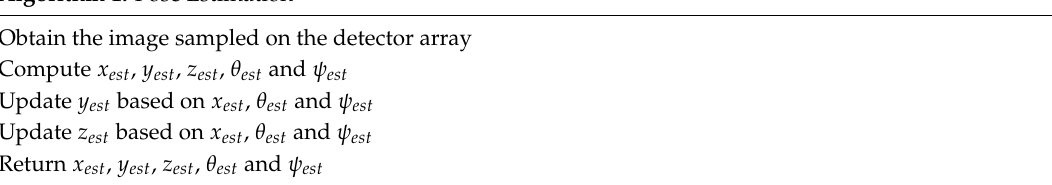
Algorithm 1. Pose